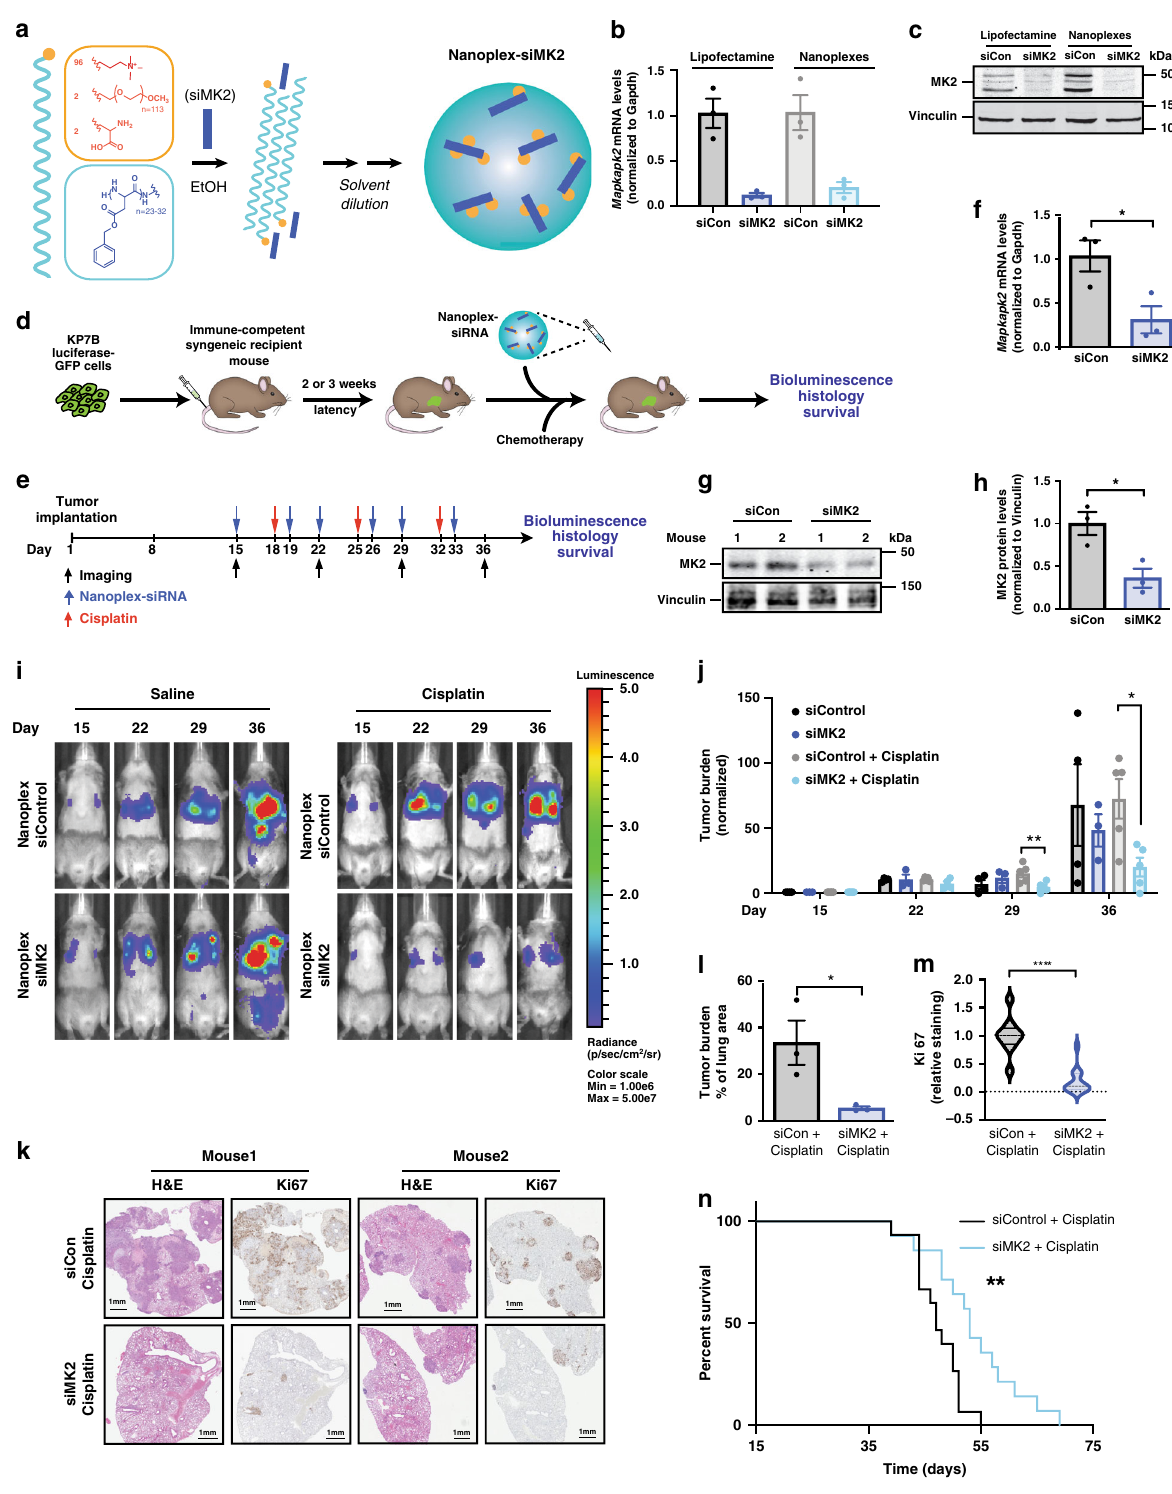
Fig. 3A; “ Methods ” ) 38 . Nanoplexes containing fl